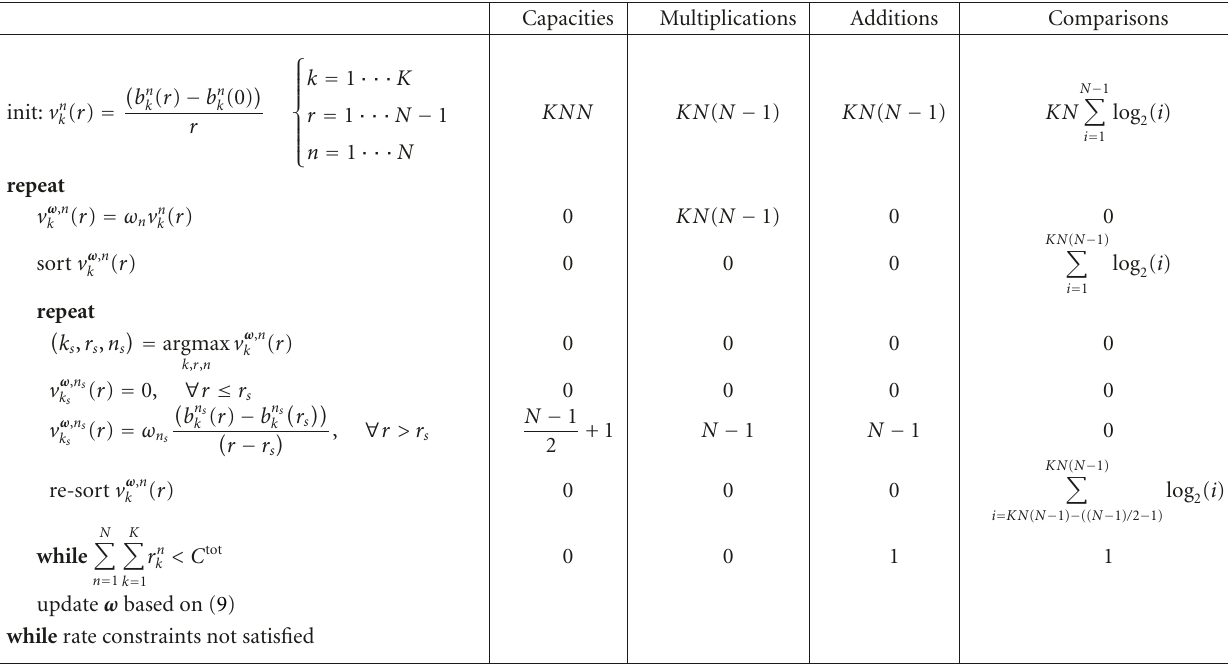
Algorithm 4: Multiuser resource allocation algorithm.